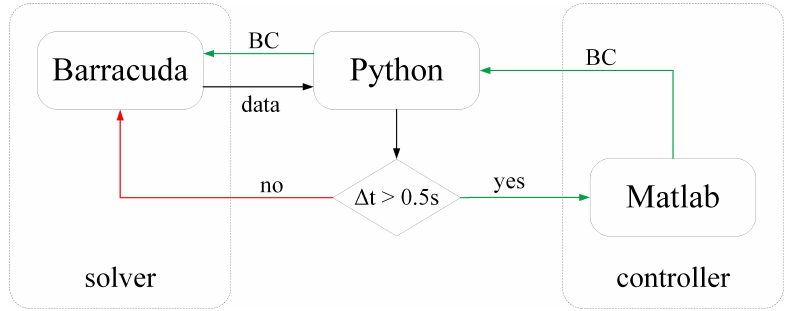
Figure 5. Co-simulation approach to enable transient control of Barracuda [22] (BC refers to boundary